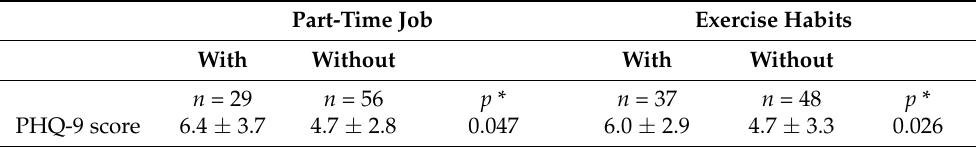
Table 2. Comparison of PHQ-9 scores with and without part-time job and exercise habits. Part-Time Job Exercise Habits With Without With Without